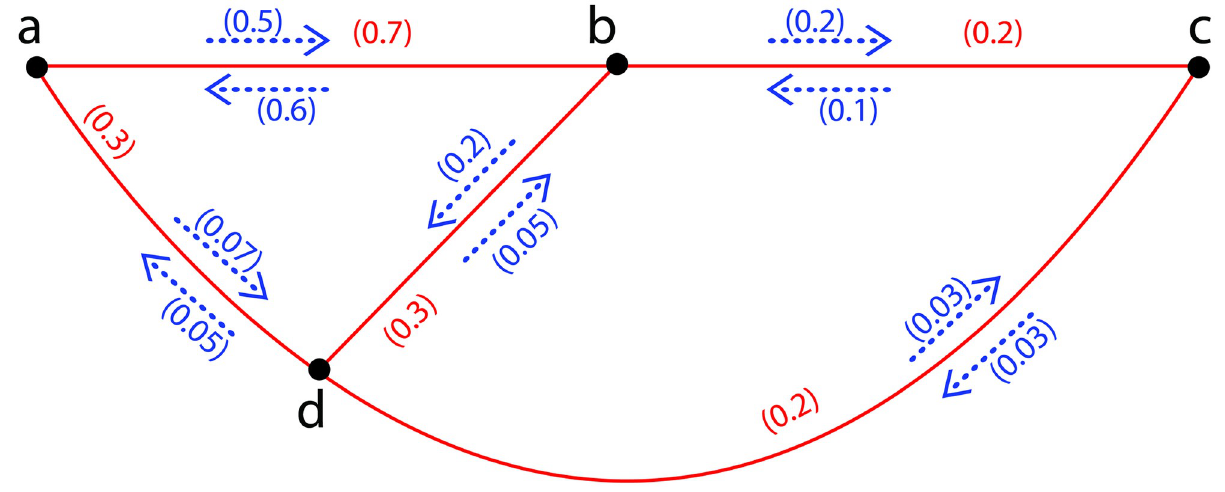
Fig 8. A FIG with CCDV and CCIV